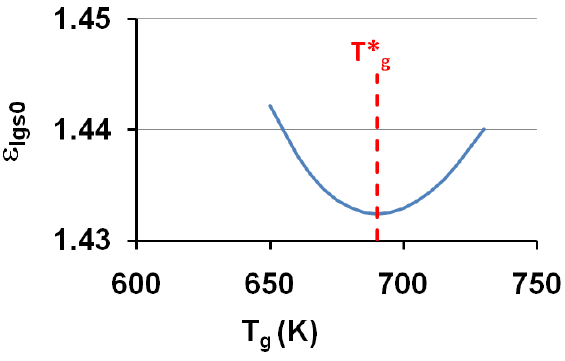
= T equal to 2ls g through lgs0